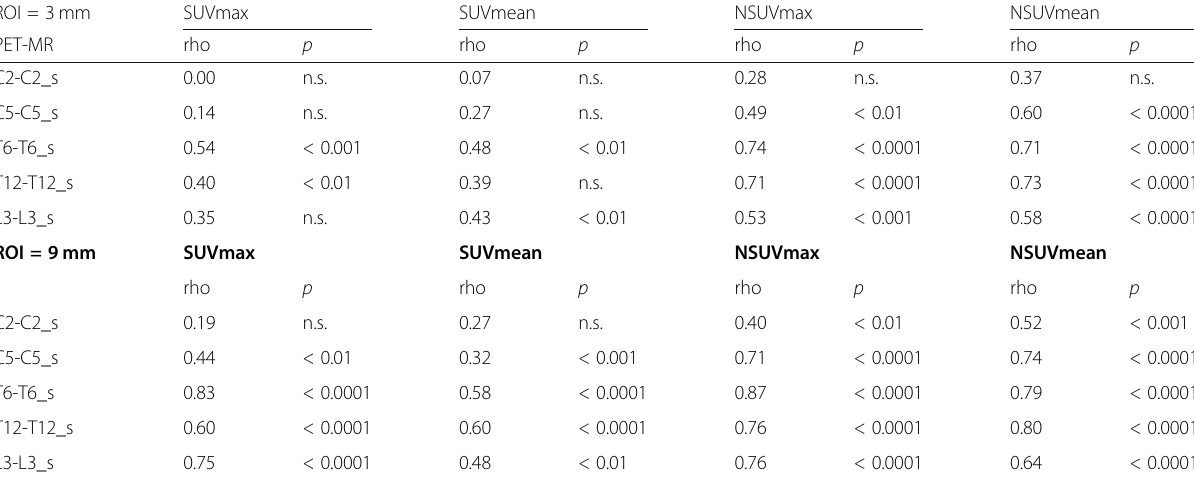
Table 3 Spearman correlation between spinal cord and marrow [ 18 F]FDG uptake at the same vertebral level for PET-MRI images with 3 – 9 mm ROI/VOI